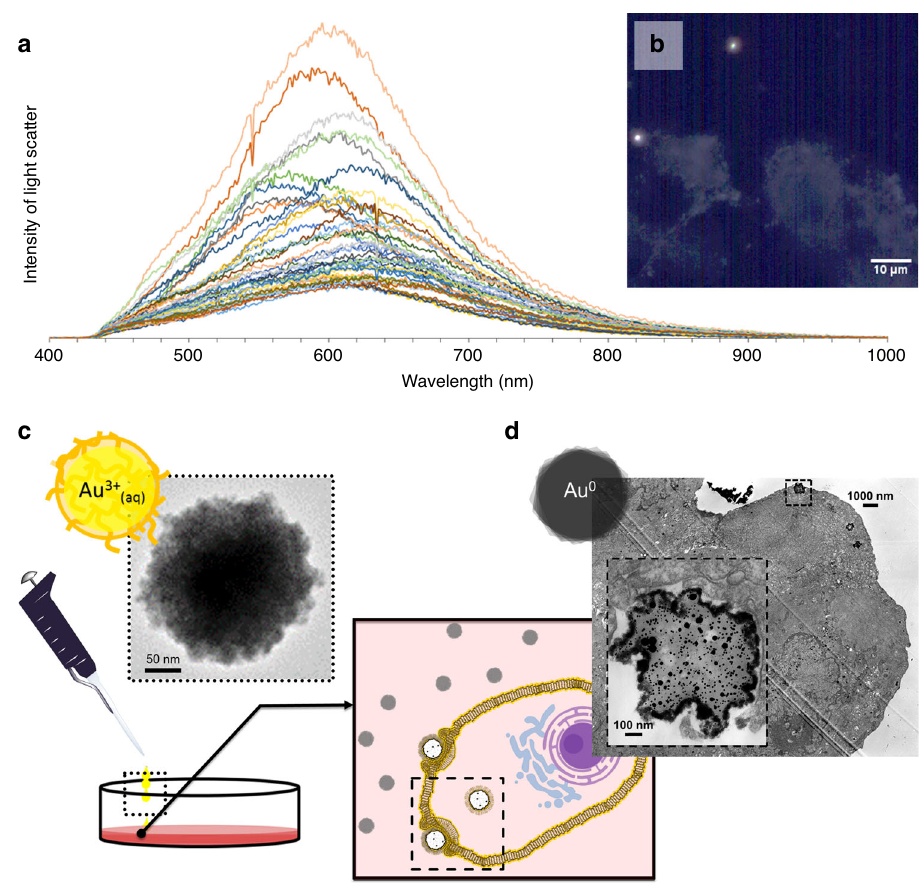
Fig. 2 Con fi rmation of in vitro reduction occurring en route. a Spectral intensity of light scatter from MCF-7 cells treated with Au – PEG clusters ( n = 44 spectra), as distinct from untreated MCF-7 cells obtained through hyperspectral enhanced dark fi eld imaging. b Corresponding enhanced hyperspectral dark fi eld image mapping of nanoparticles generated through Au – PEG treatment to MCF-7 cells with negative fi ltering with untreated MCF-7 cells (Supplemental Fig. 1e) to ensure no false-positive nanoparticle mapping. Scheme ( c , d ) with representative TEM images describing the reduction of ionic Au – PEG clusters ( c ), upon their interaction with cells ( d